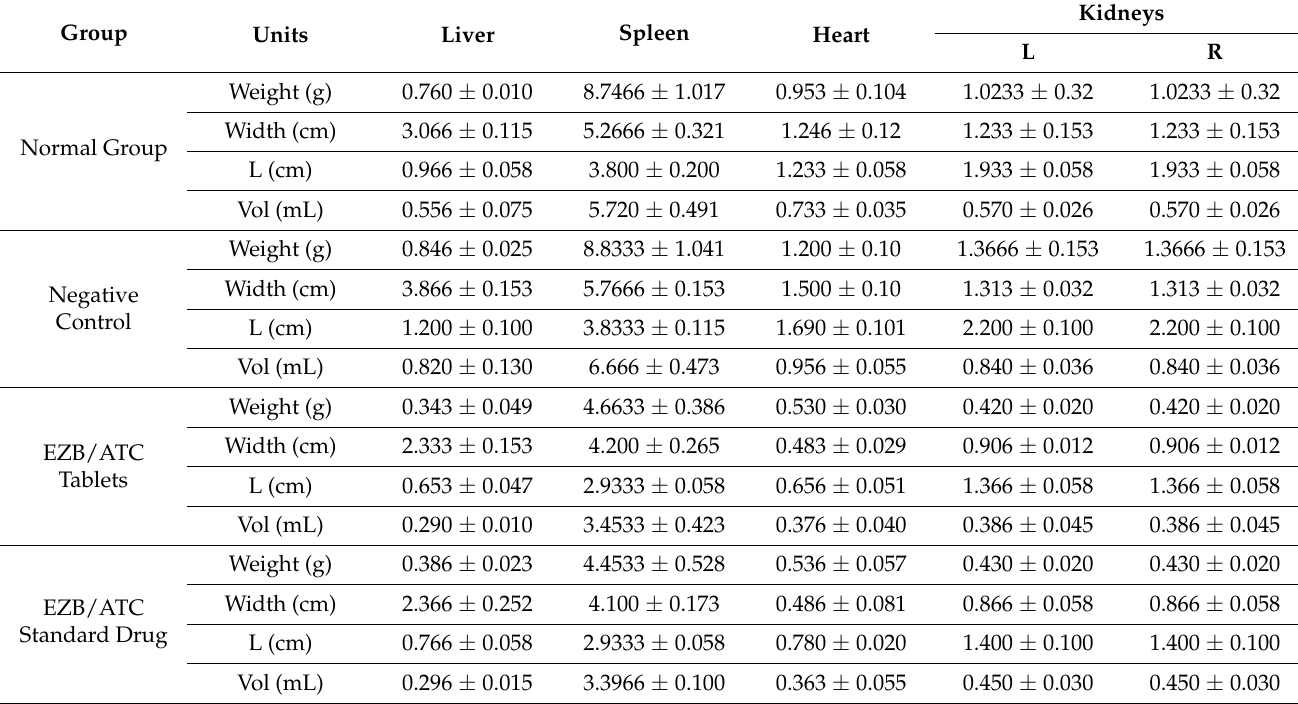
Table 5. Effect of atorvastatin and ezetimibe on vital organs of rats in preventive study.